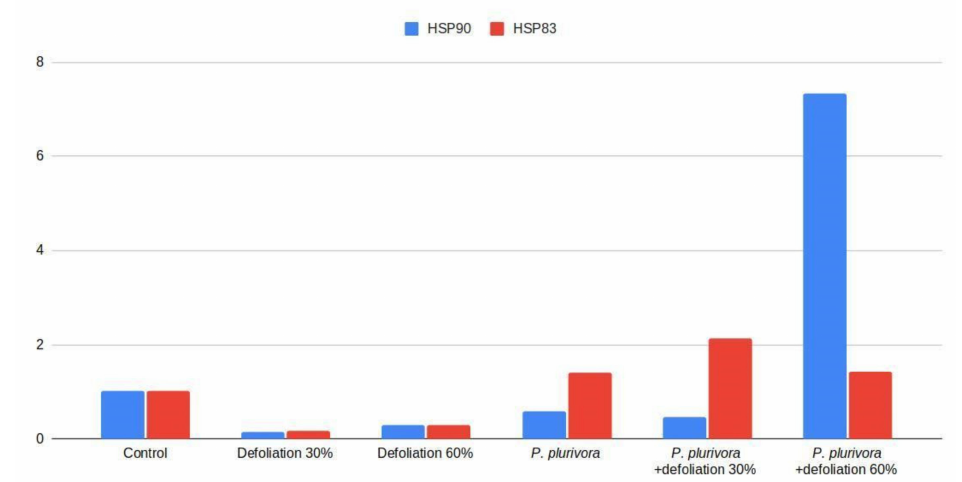
Figure 5. Relative expression level of Hsp90 and Hsp83